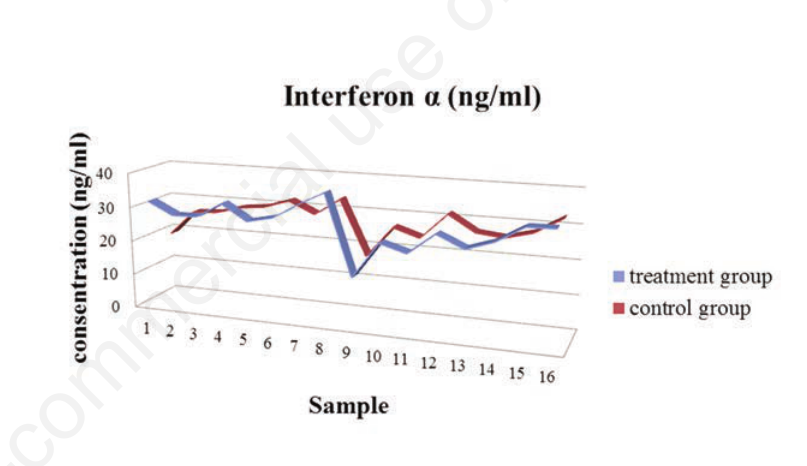
B protein (a) and control samples showing live B protein (no brown image appears) κ κ